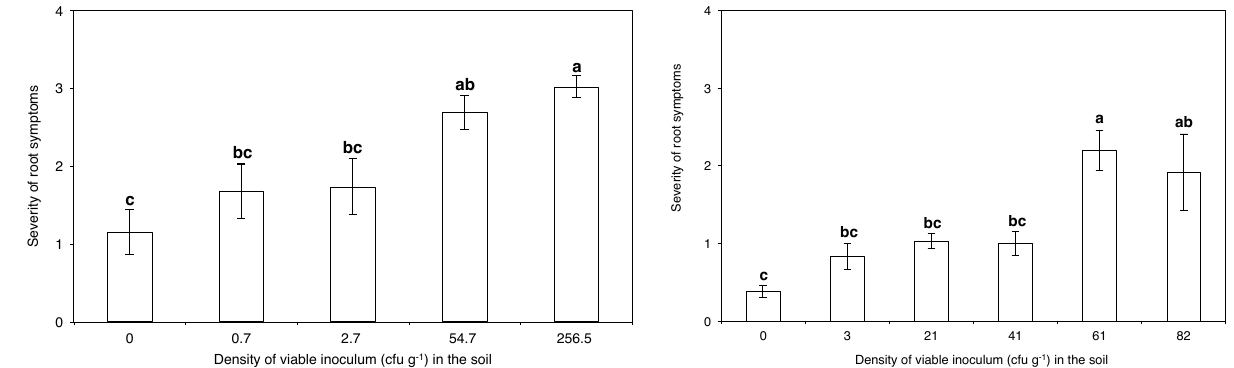
Density of viable inoculum (cfu g -1 ) in the soil Figure 2. Mean severity of root disease symptoms recorded for cork oaks growing in soils infested with different numbers of Phytopthora cinnamomi chlamydospores. Lines are standard errors of ten replicates (Experiment 1, left chart) or six rep- licates (Experiment 2, right chart). Bars with different letters differ significantly according to Tukey´s HSD test ( P